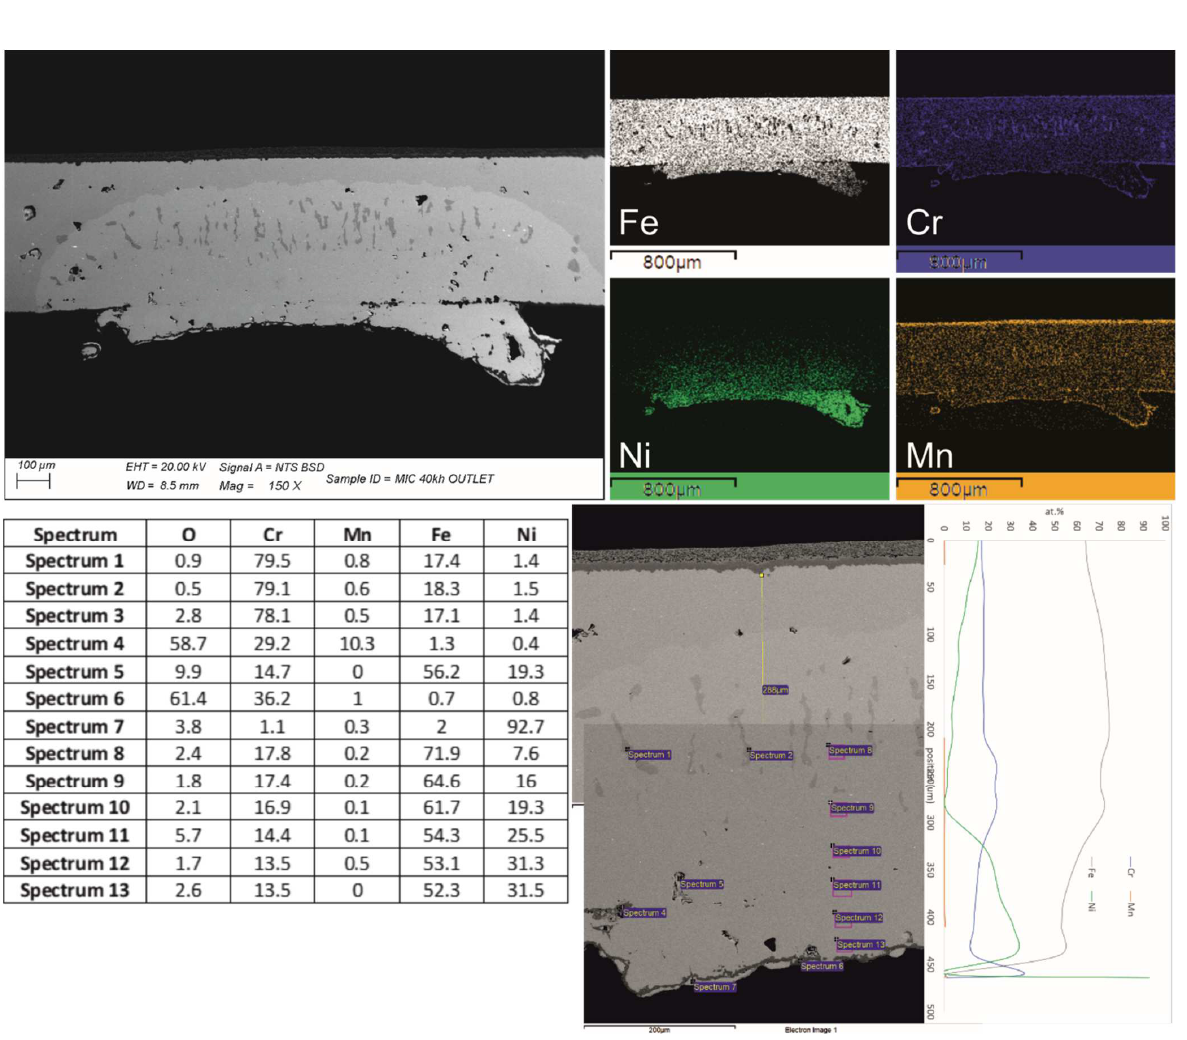
Figure 10. Cross-section of the footprint of interaction between the Ni-contacting layer and the in- terconnect with elemental distribution X-ray mapping and a table of analyses. interconnect with elemental distribution X-ray mapping and a table of analyses.